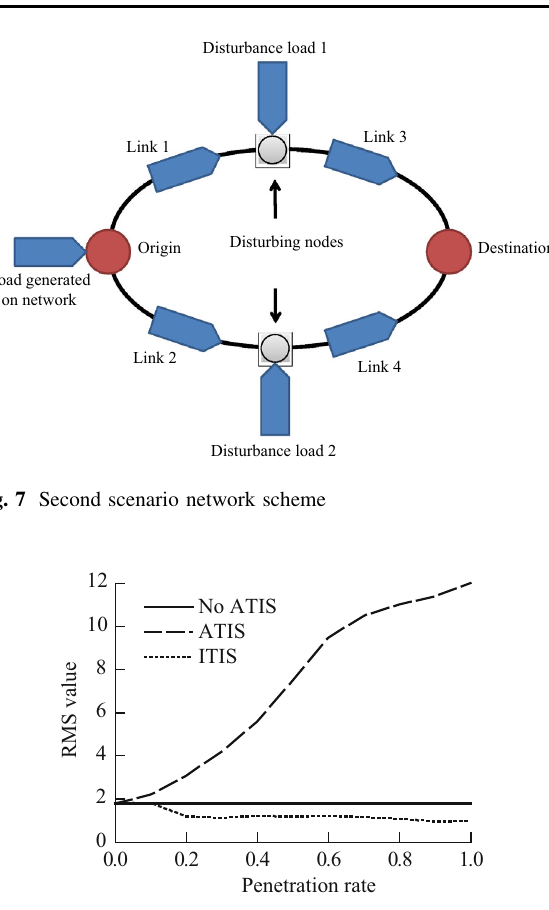
Fig. 8 RMS of travel time difference between two paths in different information dissemination strategies for second